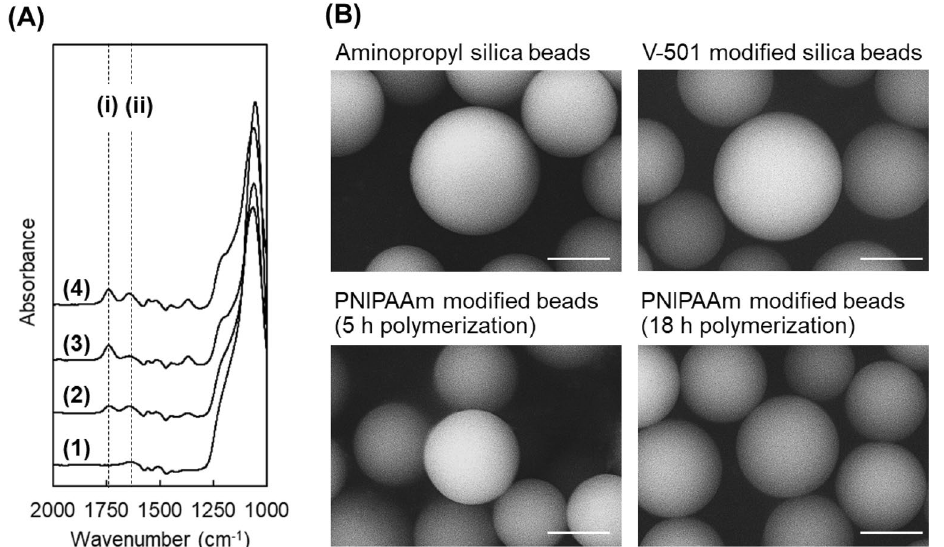
Figure 2. Characterization of the prepared beads. ( A ) Fourier transfer infrared spectra of the prepared beads. The dashed lines (i) and (ii) indicate the peak attributed to C=O stretching vibrations and N–H bending vibrations, respectively. ( B ) SEM images of the prepared beads. (1) aminopropyl silica beads, (2) V-501 immobilized silica beads, (3) PNIPAAm modified silica beads prepared via polymerization for 5 h, and (4) PNIPAAm modified silica beads prepared via polymerization for 18 h. Scale bars denote 5